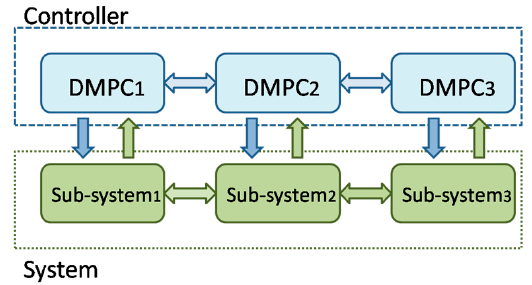
Figure 2. Schematic representation of the distributed model predictive control (DMPC) strategy.